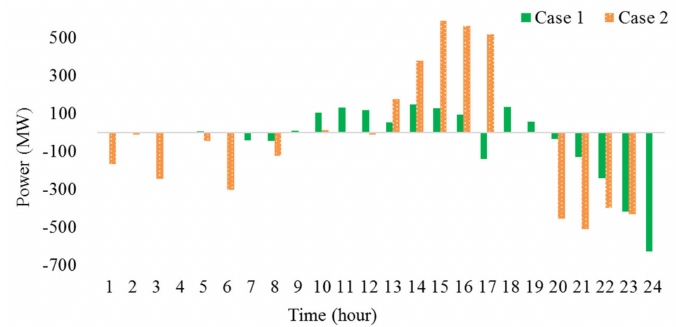
Figure 13. The power outputs of pumped storage in Case 1 and Case 2.